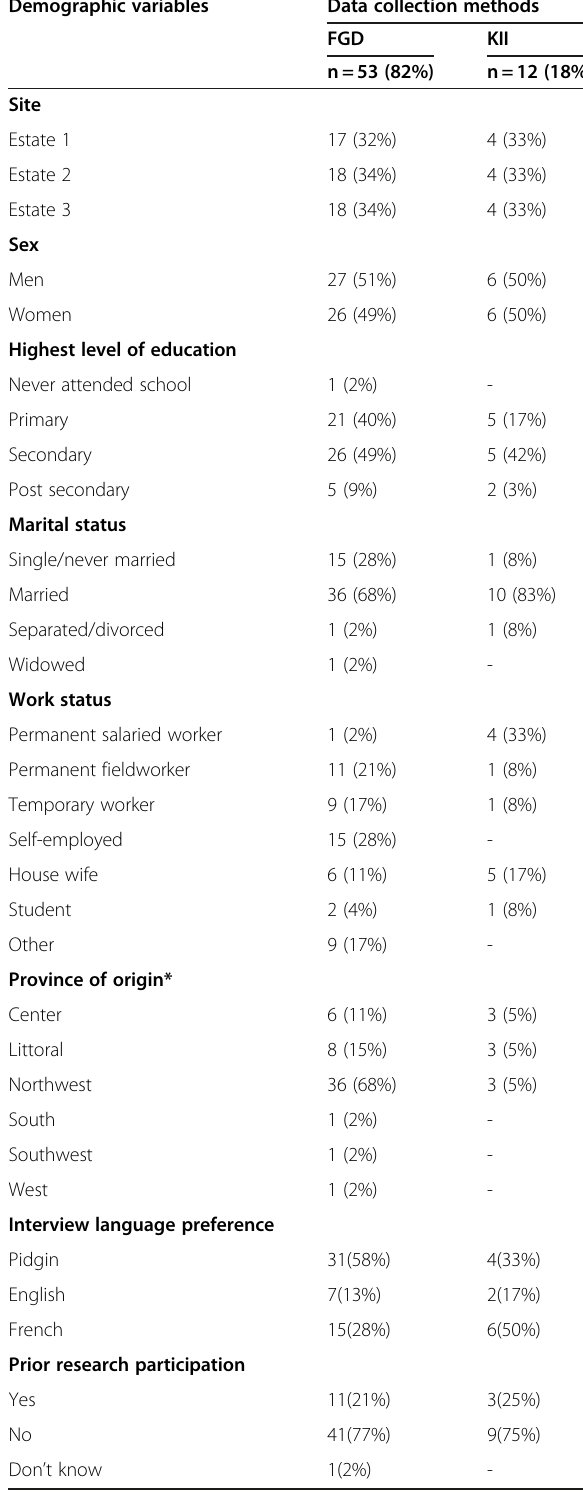
Table 1 Characteristics of plantation FGD and KII participants in Cameroon, August-October